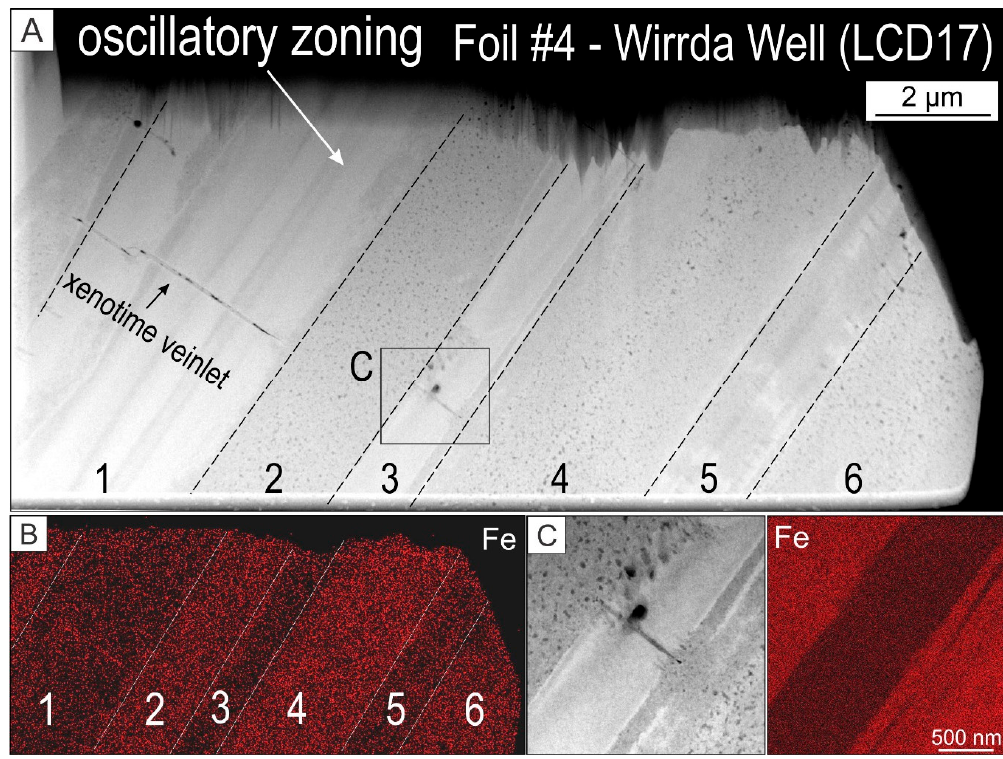
Figure 6. ( A ) HAADF STEM images ( A and C ) and EDS STEM maps for Fe ( B and D ) for Wirrda Well-Donington zircon showing crystal oscillatory zoning ( A and B ). The dark bands (even numbers) were enriched in Fe and show mottled texture in the image, but not on the Fe map ( B ). Note that the oscillatory banding was crosscut by a xenotime-bearing veinlet (extended map shown in Supplementary Materials C, Figure S3). ( C , D ) Higher resolution maps showing the interface between light and dark bands confirmed that the mottled texture ( C ) was not reflected in the Fe distribution ( D ).